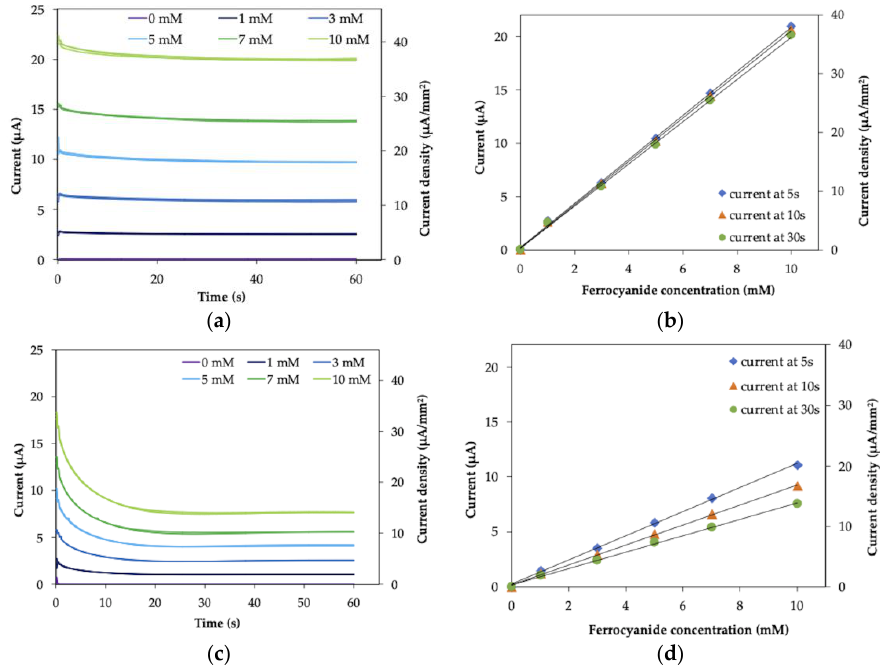
Figure 3. Response curves: ( a ) IDE WE - IDE CE mode; ( c ) IDE WE - plate CE mode, and the correlations between current and ferrocyanide concentration: ( b ) IDE WE - IDE CE mode; ( d ) IDE WE - plate CE mode, of chronoamperometry (CA) measurement of various concentrations of ferrocyanide mixed in ferricyanide with a total concentration of 100 mM. A potential of +0.4 V vs. Ag/AgCl was applied to observe the oxidation current of ferrocyanide. ( b , d ) are the plots of the resulting currents obtained at 5, 10 or 30 s after the potential application against the ferrocyanide concentration. Each measurement of ferrocyanide concentration was carried out in triplicate ( n = 3).